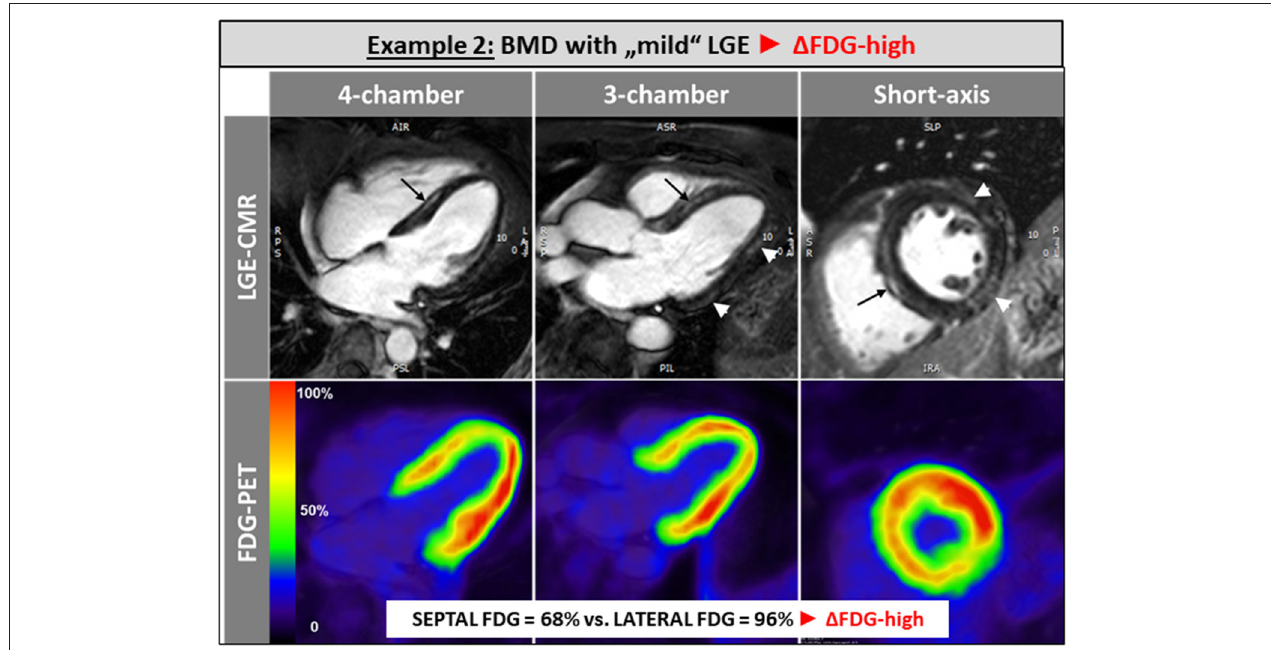
FIGURE 3 | Patients in the 1 FDG-low group were characterized by rather large areas of LGE in the LV lateral wall compared to the septal wall, but showed less extensive FDG uptake in the lateral wall compared to the 1 FDG-high group.